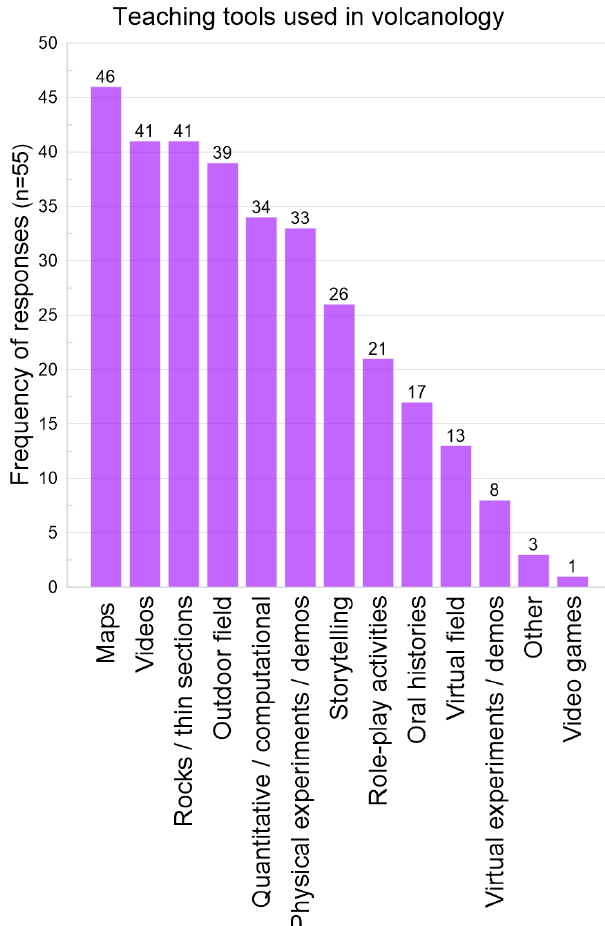
Figure 2: Tools utilised by respondents to teach about volcanic phenomena and their impacts. Note that re- spondents could select multiple